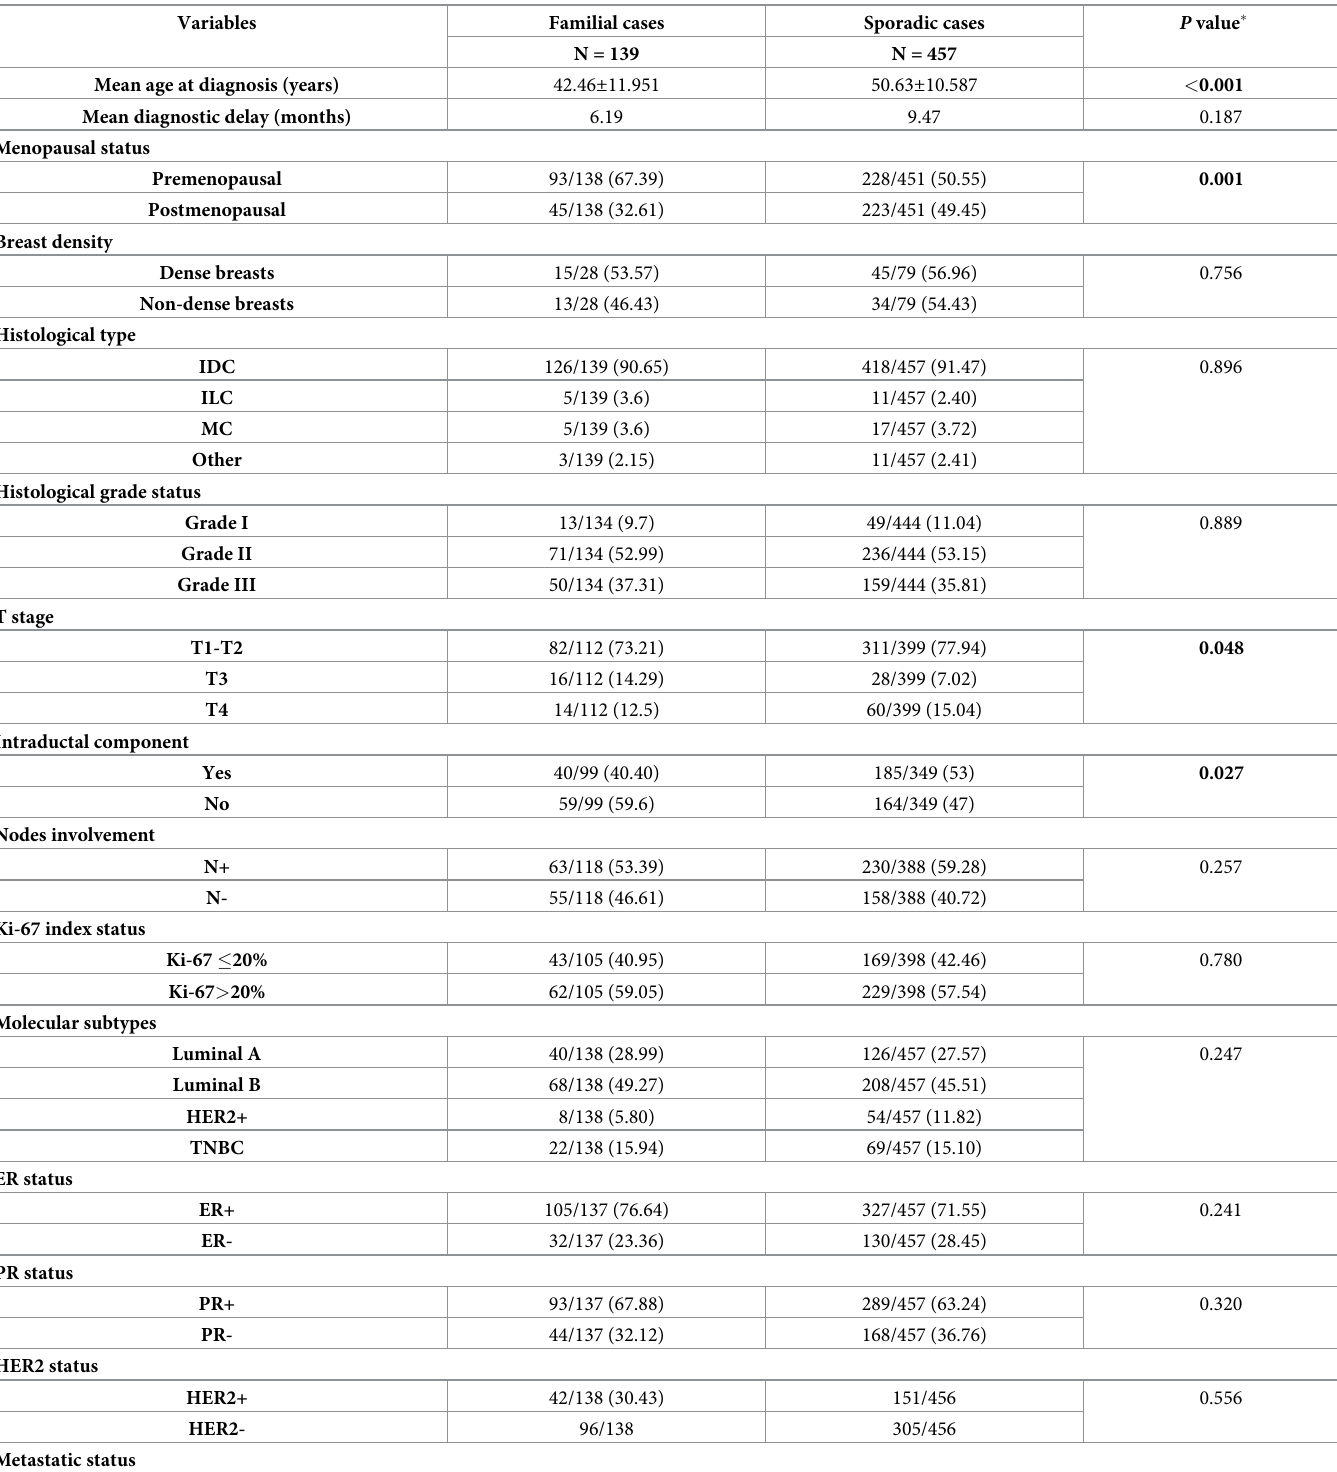
Table 1. Comparison of epidemiological and clinicopathological parameters between familial and sporadic breast cancer